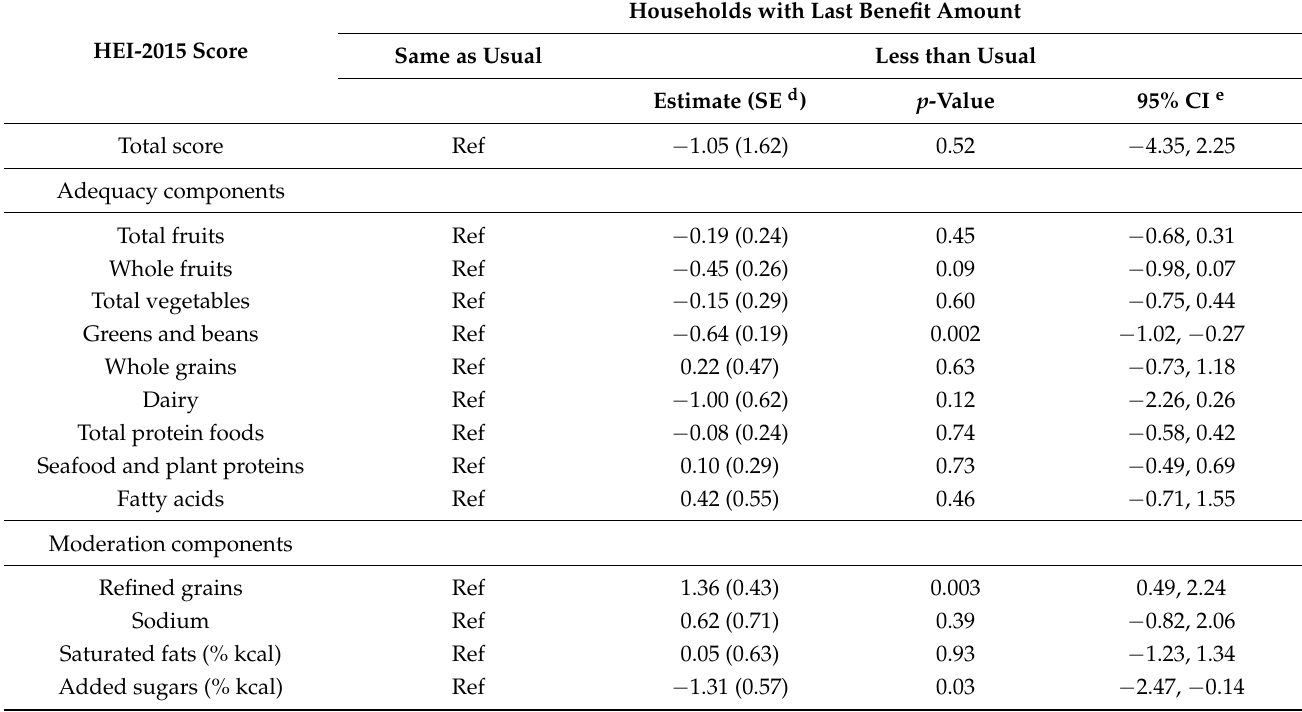
Table 4. Association a of benefit reduction with HEI b -2015 total and component scores of food-at-home purchases among SNAP c households in the National Household Food Acquisition and Purchase Survey 2012–2013 ( n =